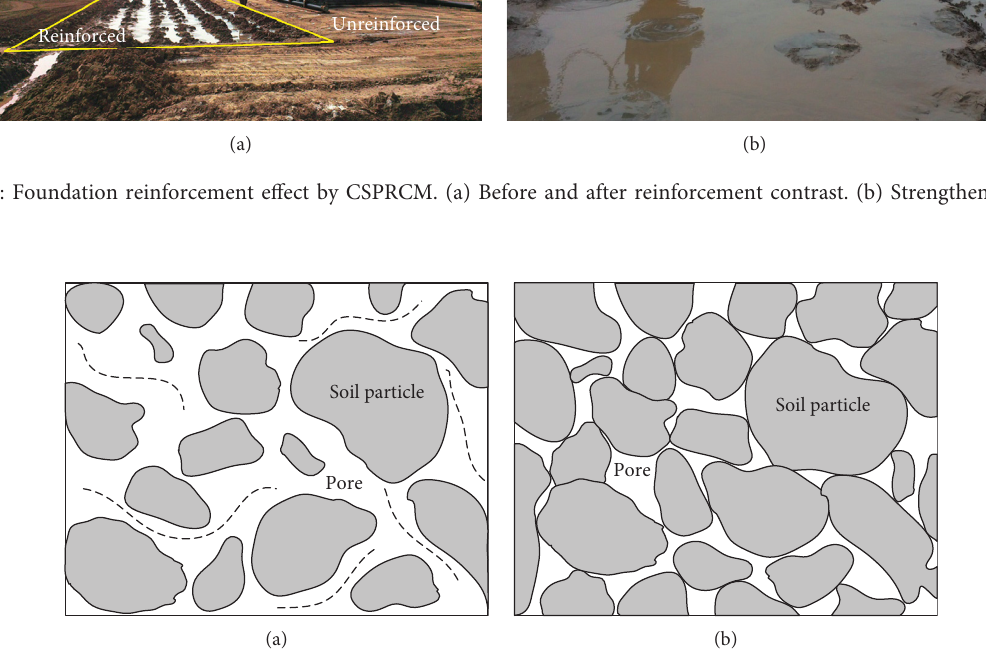
Figure 12: Soil structure changes before and after reinforcement. (a) Before reinforcement. (b) After